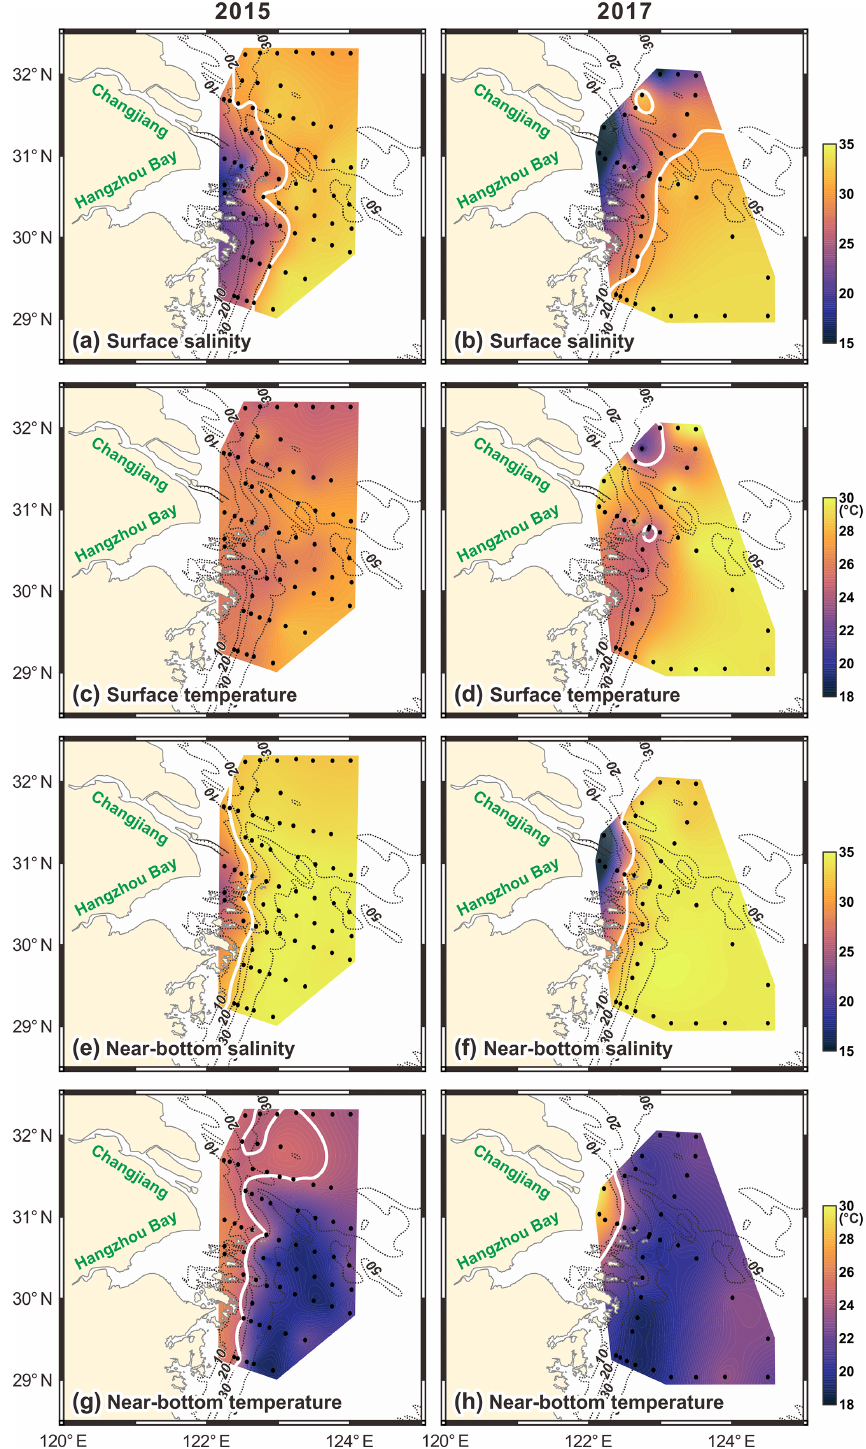
Figure 3. Maps of surface salinity (a, b) , surface temperature (c, d) , near-bottom salinity (e, f) and near-bottom temperature (g, h) from the surveys in 2015 (a, c, e, g) and 2017 (b, d, f, h) . The 30 and 24.5 ◦ C isolines are shown as white